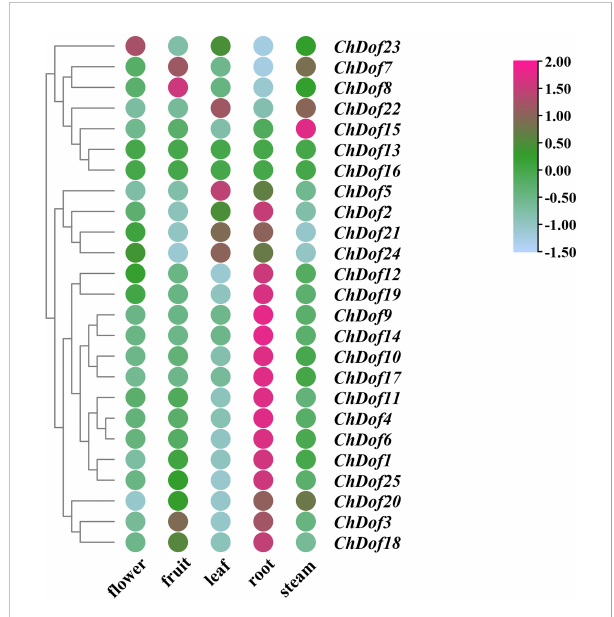
FIGURE 7 Expression pattern of ChDofs in different tissues of C. humilis . The expression pattern was generated based on FPKM plus 1 after log2 transformation and analyzed by heatmap hierarchical